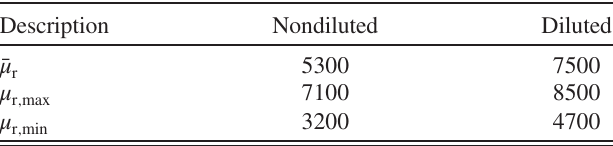
TABLE V. Average, minimum and maximum permeability for nondiluted and diluted magnet yokes calculated by using meas- urement results performed with mixed